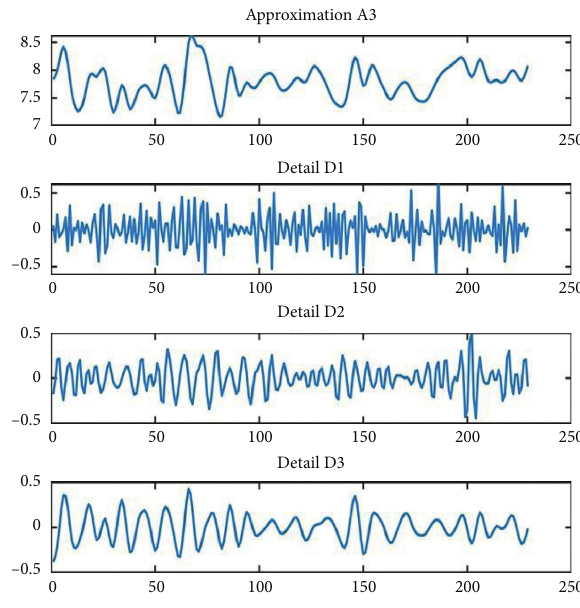
Figure 5: Wavelet decomposition of pH values at